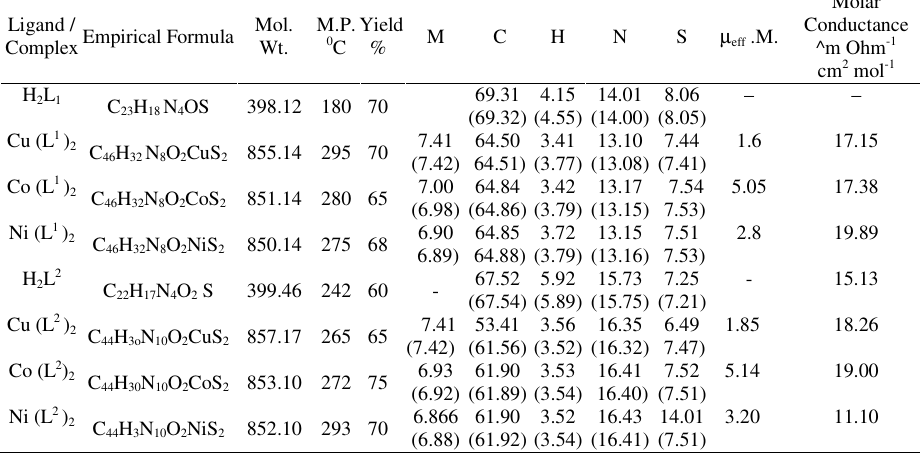
Table 1. Physical, analytical, magnetic susceptibility and molar conductance data of the ligand H L 1 and H L 2 and its complexes 2 2 Ligand / Mol. Empirical Formula Complex